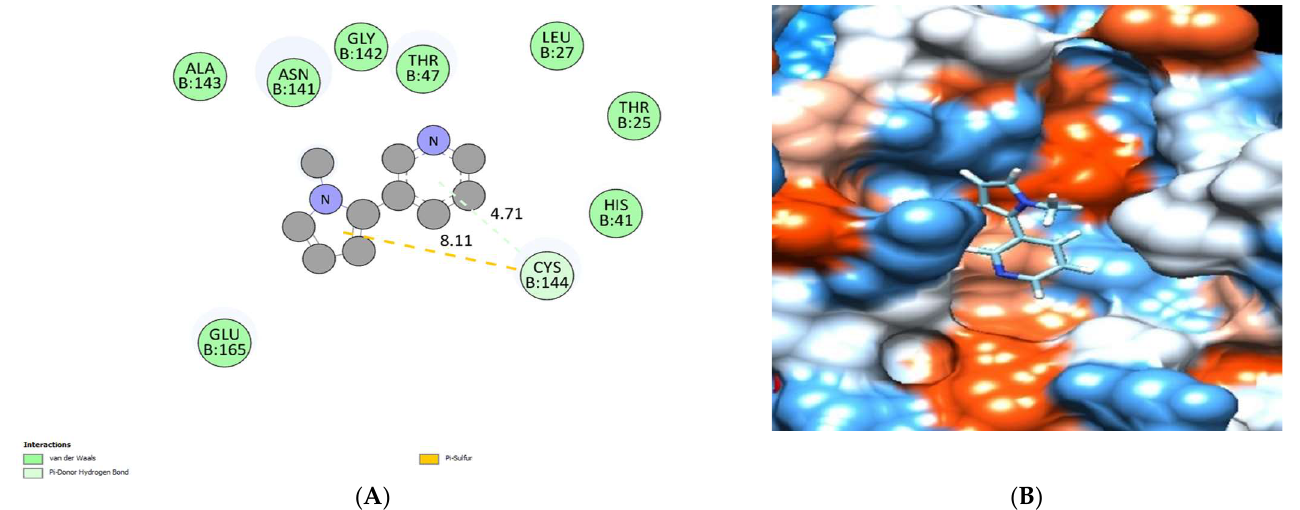
Figure 17. Nicotyrine docked in HCo-V229E main protease. Hydrogen bonds are represented in green, and the pi interactions are described in dark yellow lines ( A ), with a mapping surface showing nicotyrine occupying the active pocket of HCo-V229E main protease ( B ). The binding mode of the solanidine exhibited an energy binding of − 6.95 kcal/mol against Co-V 229E main protease, which formed a hydrogen bond at Thr 25 with a distance of 4.63 Å (Figure 18) and Table